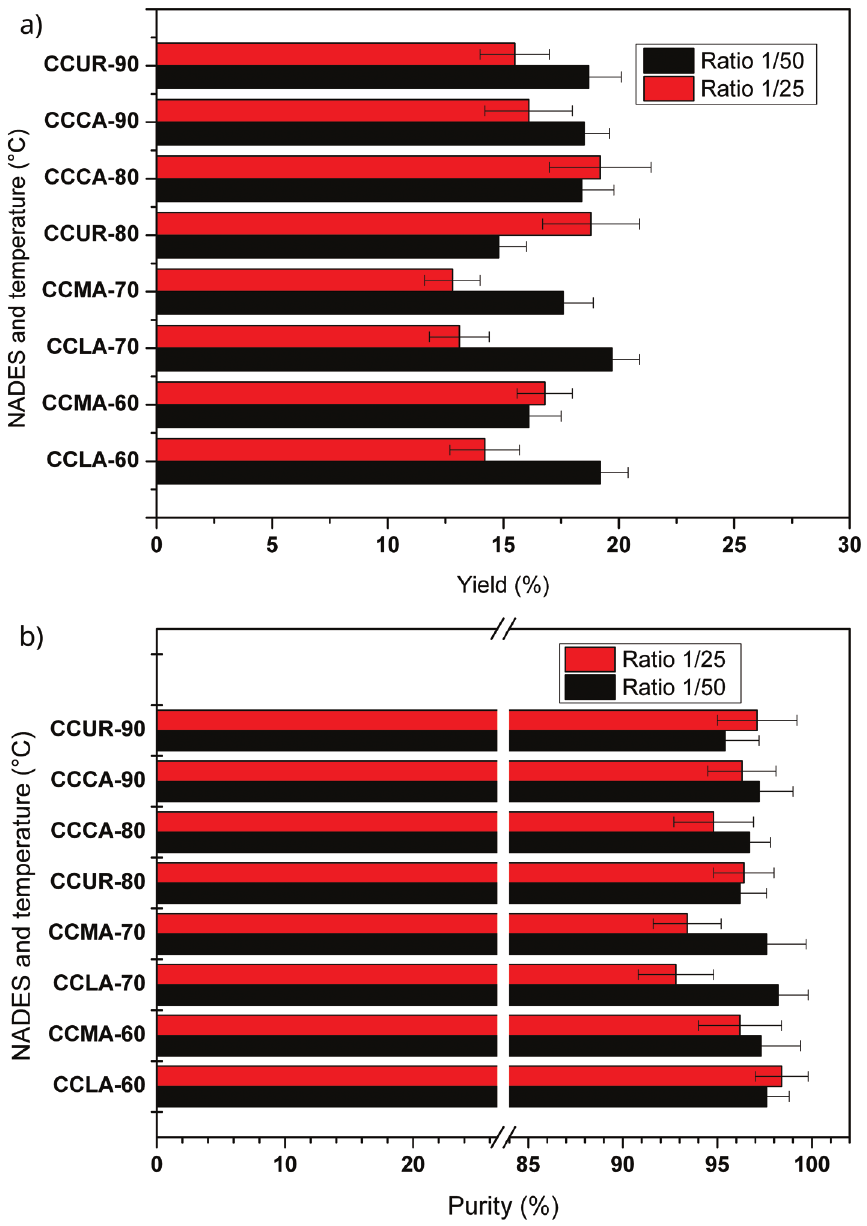
Figure 3: Chitin yield (a) and purity (b) obtained using NADES at different temperatures and shrimp shell powder ratios. Fractionation time of 6 h at 100 min -1